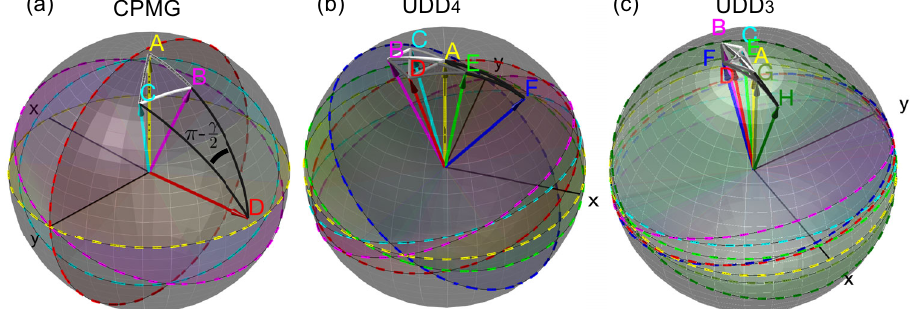
FIG. 14. Comparison of CPMG (a) with UDD 4 (b) and UDD 3 (c) rotation angles. We compose the rotations of the free-evolution periods for one unit of the sequence using the Rodrigues formula. The last composition gives rise to the black spherical triangles. In (a), we show ∢ CDB , which gives the total rotation angle γ . We find that geometrically the rotation angle of CPMG is